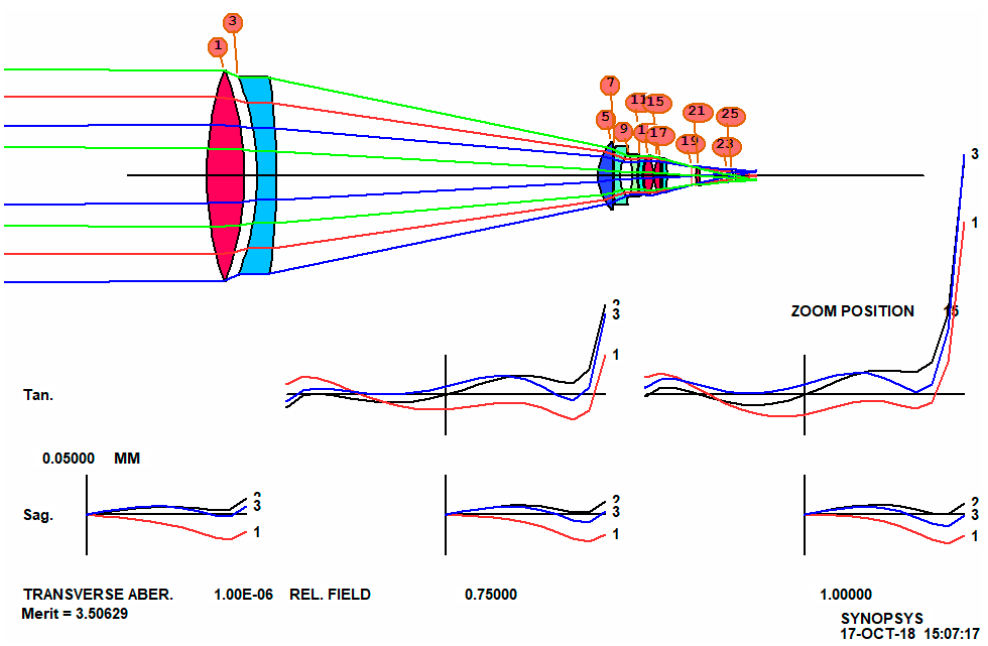
Figure 14. Zoom lens at zoom 15.